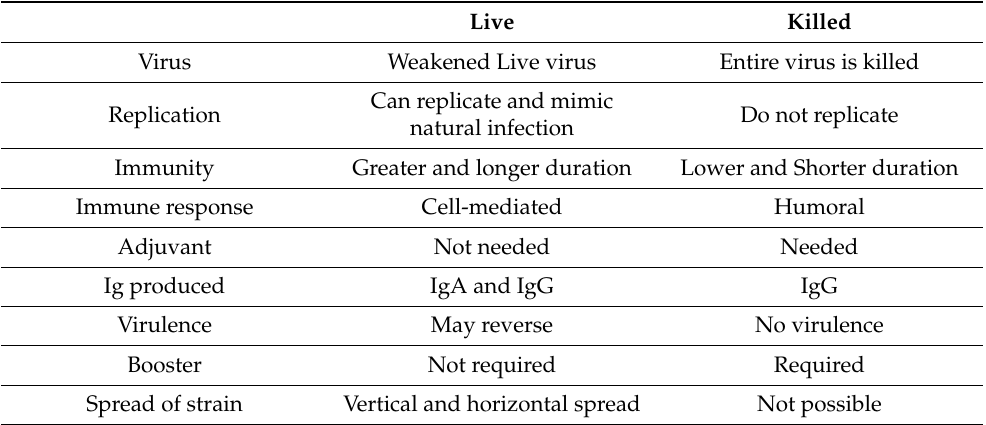
Table 1. The differences between live-attenuated and killed vaccines.